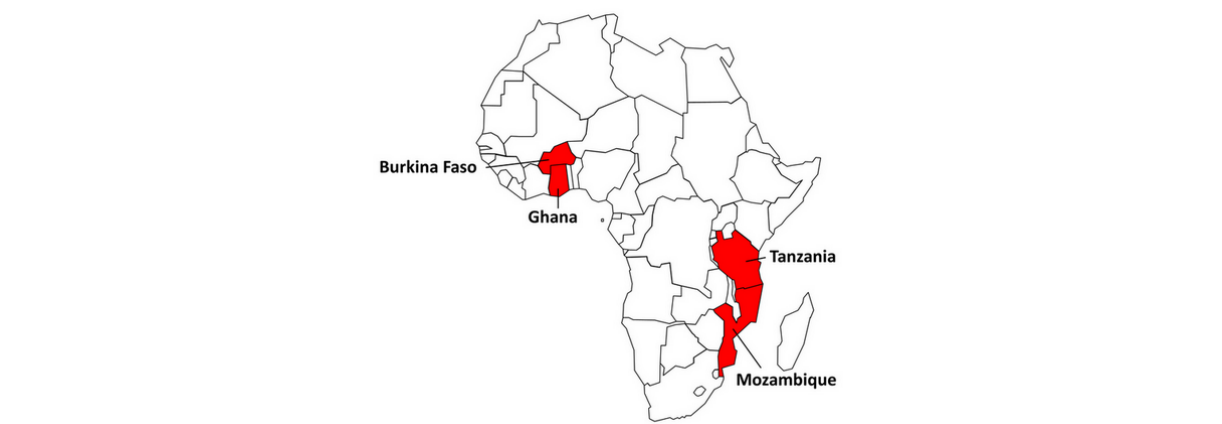
Figure 2. Location of study countries in sub-Saharan